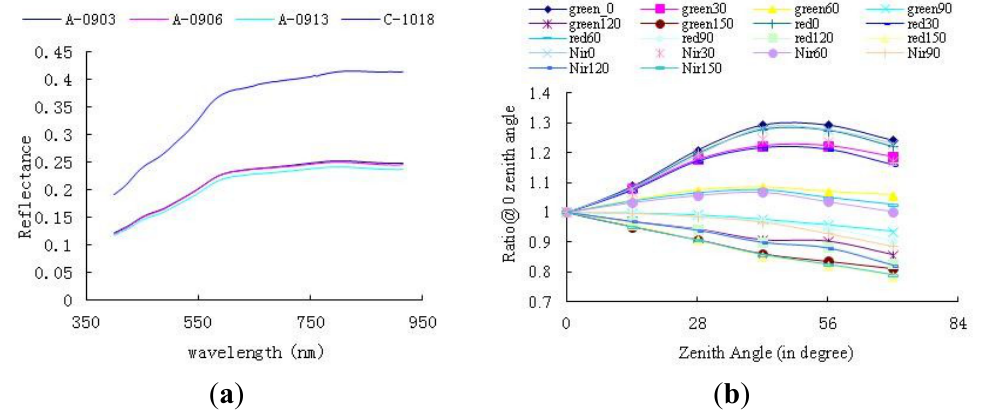
Figure 3. ( a ) Average reflectance of Area A acquired on 3, 6, and 13 September, and average reflectance of Area C acquired on 18 October. ( b ) Ratios of band-weight reflectance of Beijing-1/MS at 0 zenith angle compared to that of other zenith angles at the same azimuth angle. Numbers in the legend refer to the azimuth angle (in degrees).